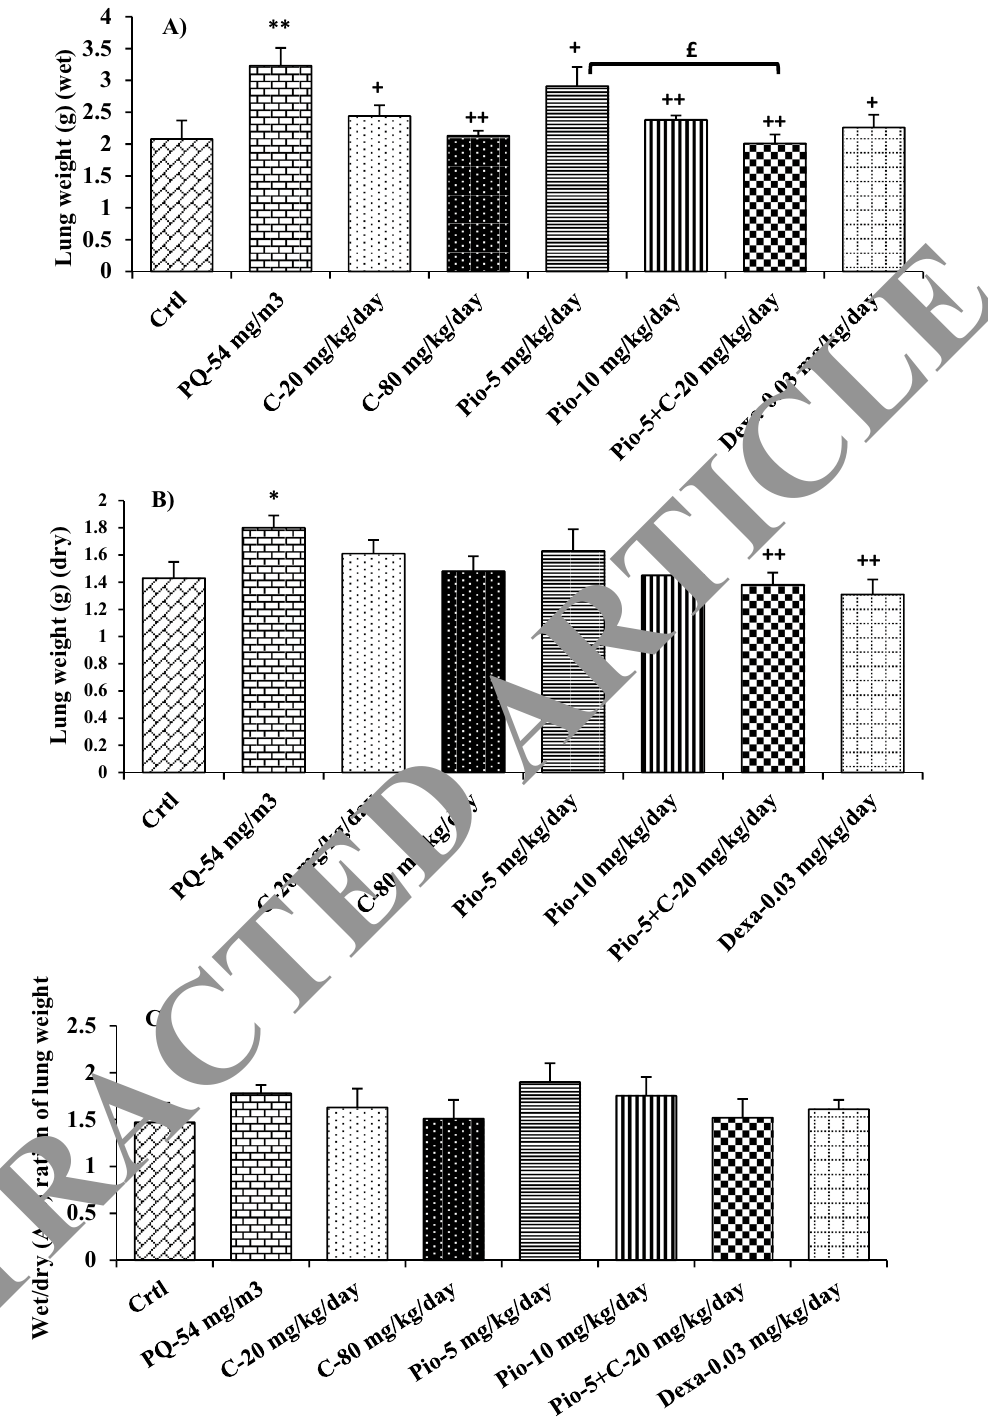
Figure 1. Comparisons of lung wet ( A ) and dry ( B ) weight and wet/dry weight ratio (W/D) of the lung ( C ) between control group (Ctrl), group exposed to paraquat aerosol at doses of 54 mg/m 3 (PQ-54 mg/m 3 ), groups exposed to PQ-54 mg/m 3 and treated with 5 and 10 mg/kg/day pioglitazone (Pio-5 mg/kg/day and Pio-10 mg/kg/day), 20 and 80 mg/kg/day carvacrol (C-20 mg/kg/day and C-80 mg/kg/day), 0.03 mg/kg/day dexamethasone (Dexa-0.03 mg/kg/day) and 5 mg/kg/day pioglitazone + 20 mg/kg/day carvacrol (Pio-5 mg/ kg + C-20 mg/kg). + p < 0.05 compared to the PQ-54 mg/m 3 , # p < 0.05 compared to dexamethasone, £ p < 0.0 comparisons between Pio-5 with Pio-5 mg/kg/day + C-20 mg/kg/day group. Data are presented as mean ± SEM (n = 6 in each group). Comparisons between different groups were made using one-way ANOVA followed by Tukey’s multiple comparison